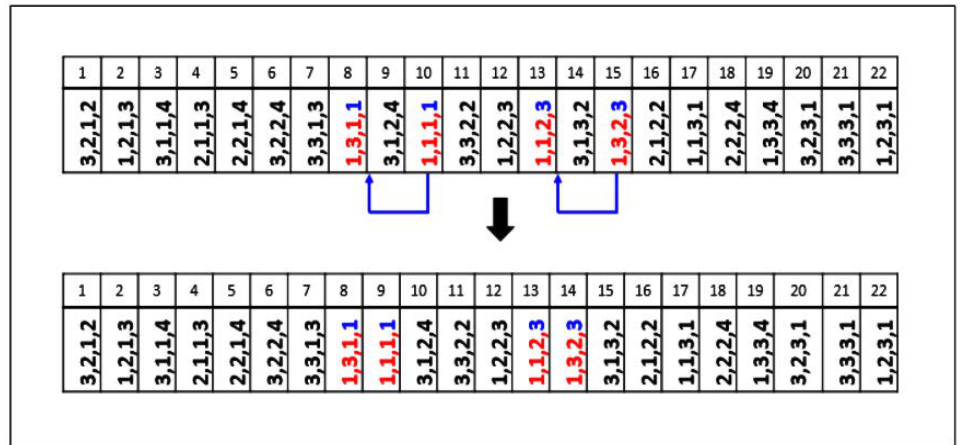
Figure 8. Local search procedure by grouping sub-lots.